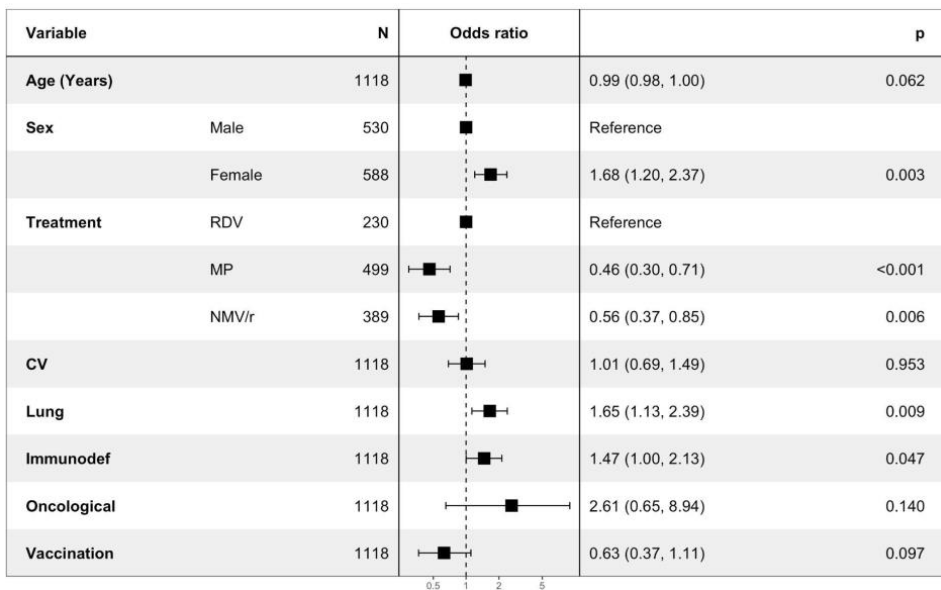
Figure 3. Logistic regression analysis of persistence of symptoms at 30 days. RDV: remdesivir; MP: molnupiravir; NMV/r: nirmatrelvir/ritonavir; CV: cardiovascular disease; Immunodef: immunode- ficiency.